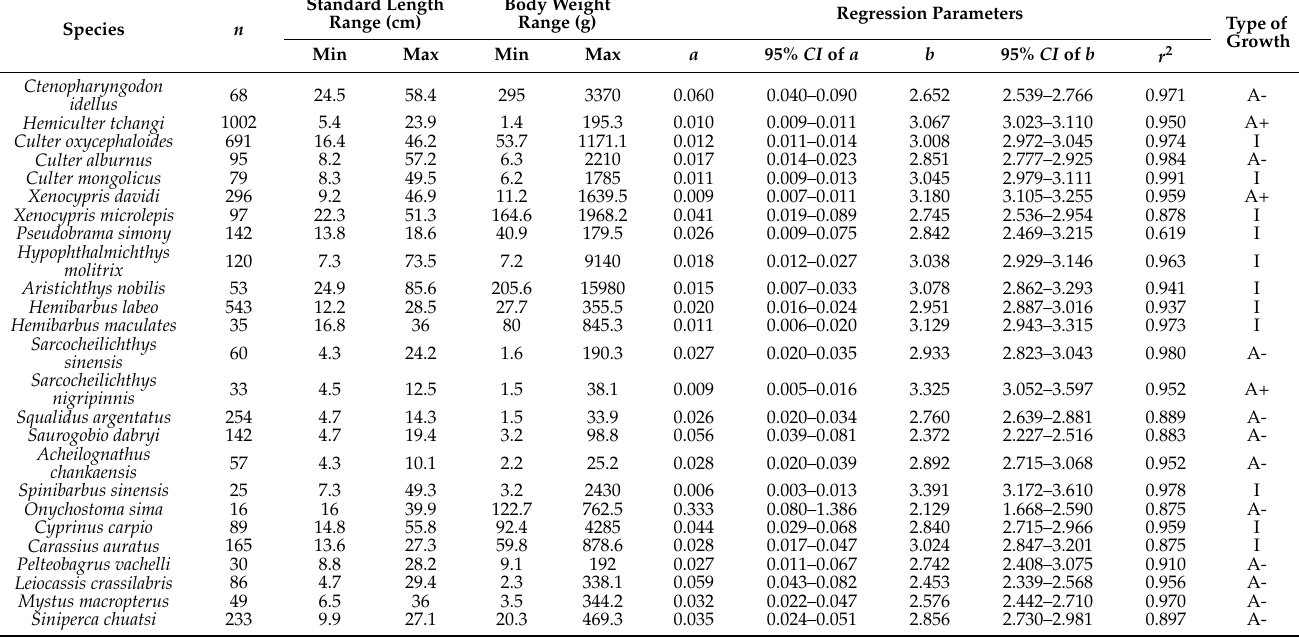
Table 2. Descriptive statistics and regression parameters of length–weight relationships (LWRs) based on the formula: BW = aSL b for 25 fish species ( IRI ≥ 10) in the midstream of the Jialing River sampled from December 2021 to November 2022. n represents sample size, a and b are regression parameters, CI is the confidence interval for parameters, r 2 is the coefficient of determination, Type of growth is determined by comparing the significance of exponent b with 3, I represents isometric growth, A- represents negative allometric growth, A+ represents positive allometric